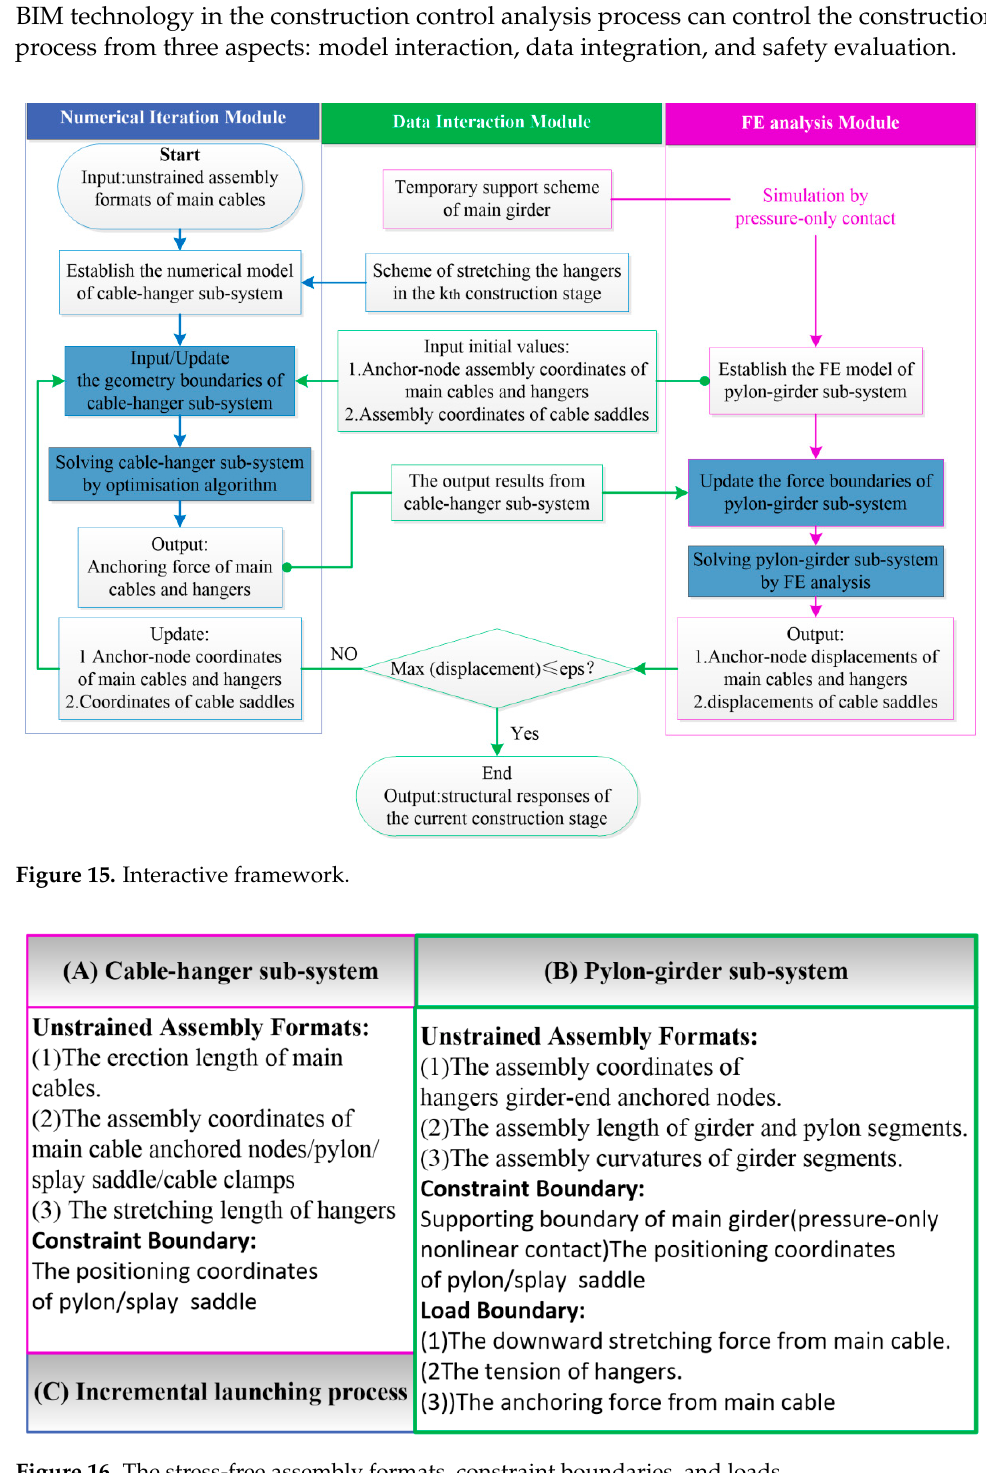
Figure 16. The stress-free assembly formats, constraint boundaries, and loads.